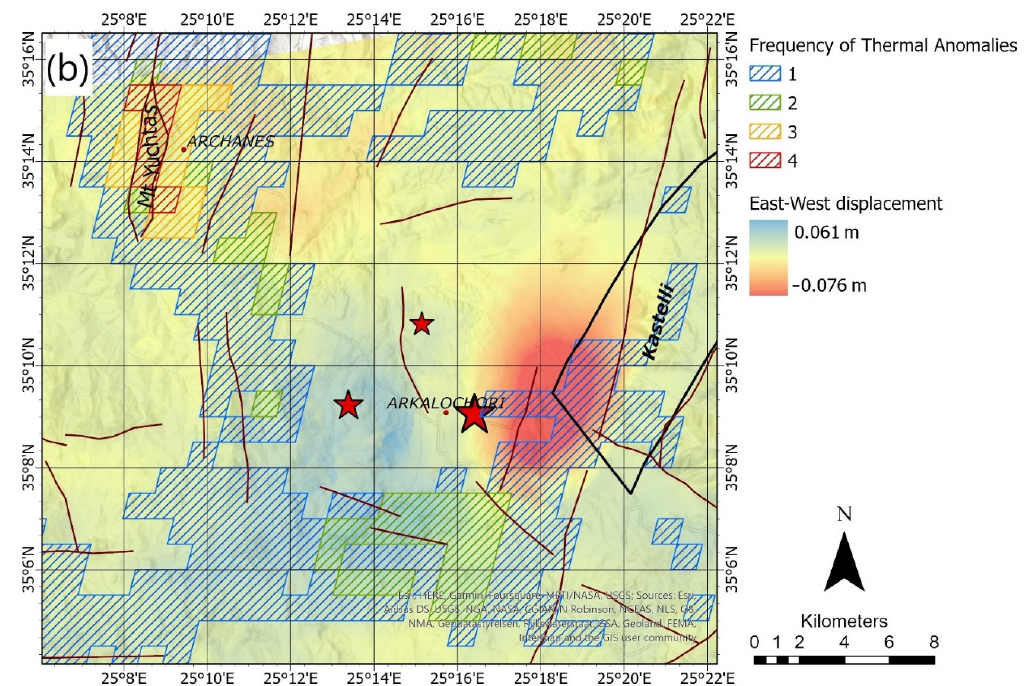
Figure 8. Displacement maps for: ( a ) the vertical (up–down); and ( b ) the E–W direction for the Central Crete earthquake overlain by the thermal anomaly frequency map. The epicenter of the main event and of the two major aftershocks are shown with red stars.